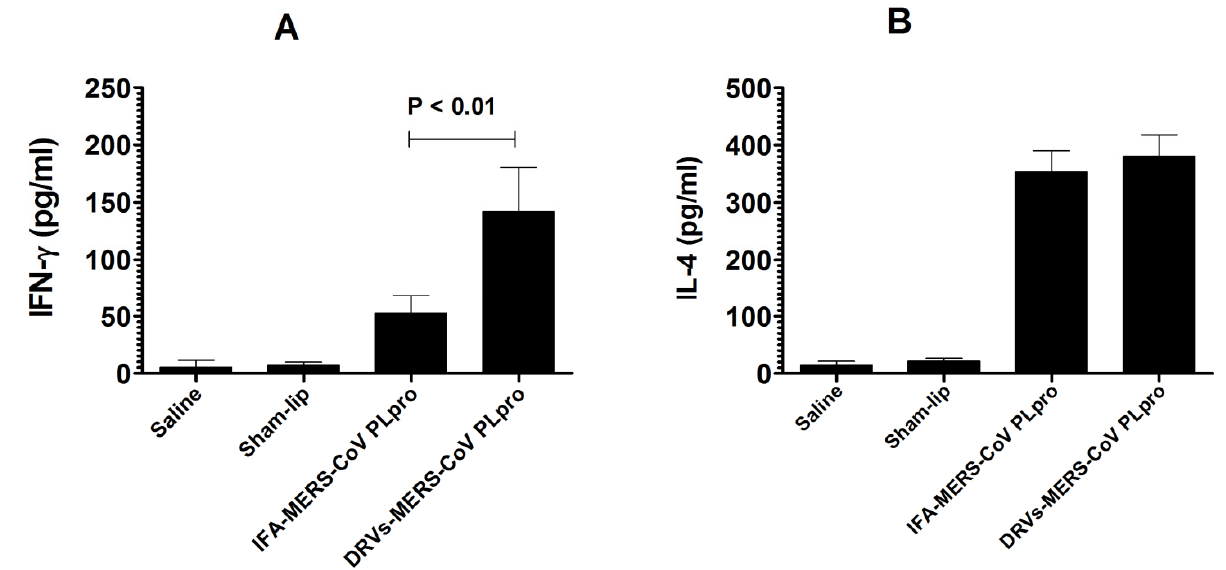
Figure 5. The splenocytes from mice immunized with DRVs-MERS-CoV PLpro produced higher levels of ( A ) IFN- γ and ( B ) IL-4. The data are represented as the mean ± SD of the values from three mice.